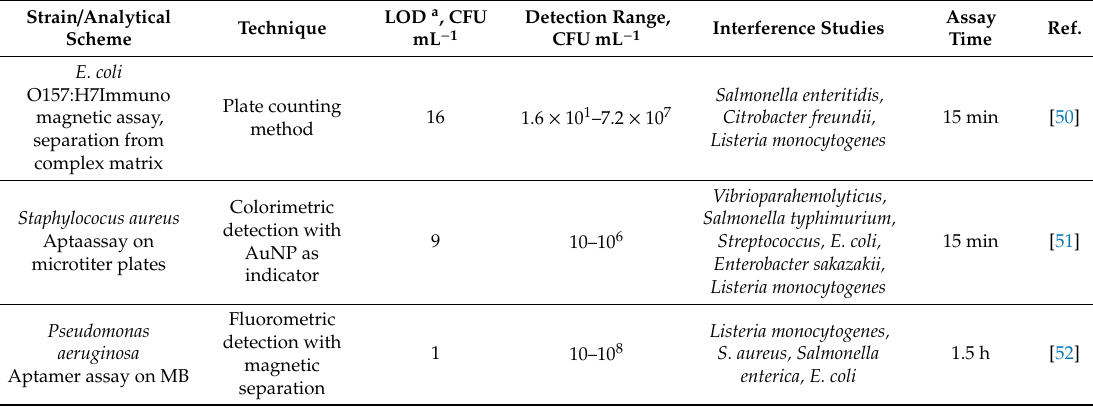
Table 2. Selected examples of optical and related immunoassays for whole bacterial cells. Strain / Analytical